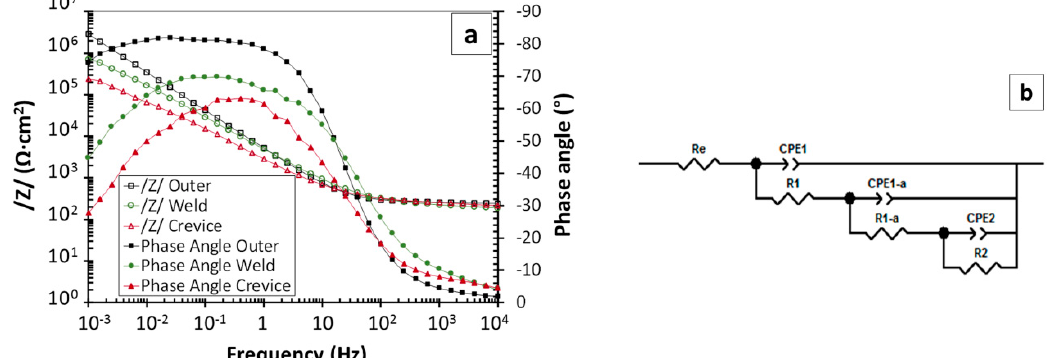
Figure 9. ( a ) EIS spectra obtained for three of the tested regions under study for the piece in Figure 1 (outer surface, weld, and crevice), using gels with 40% glycerol and KClO 4 ; ( b ) equivalent circuit required for an adequate simulation of the measurements carried out inside the crevice with gels with NaCl and with KClO 4 . Table 5. Electrochemical parameters obtained from fitting EIS measurements carried out in various regions of the part shown in Figure 1, using a gel electrolyte with 40% glycerol. Salt in the